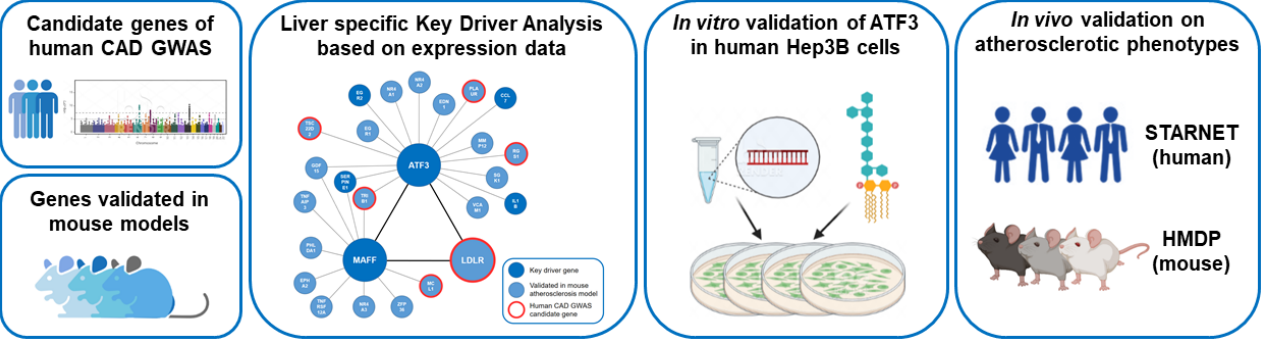
Figure 1. Workflow of the study. Human CAD GWAS candidate genes and atherosclerosis relevant genes validated in genetically engineered mouse models in combination with publicly available transcription data of both species have been used to model liver-specific gene regulatory networks followed by Bayesian Key Driver Analysis (KDA). The focus was on the transcription factor ATF3 orchestrating an atherosclerosis relevant subnetwork including MAFF and LDLR. Validation of the regulatory capacities of ATF3 have been performed experimentally in vitro in human Hep3B cells using small interfering RNA (siRNA) knockdown and in vivo in large transcriptomic studies (STARNET—human and HMDP—mouse). CAD: Coronary artery disease; GWAS: Genome wide association study; HMDP: The Hybrid Mouse Diversity Panel; LPS: lipopolysaccharide; STARNET: Stockholm-Tartu Atherosclerosis Reverse Network Engineering Task.